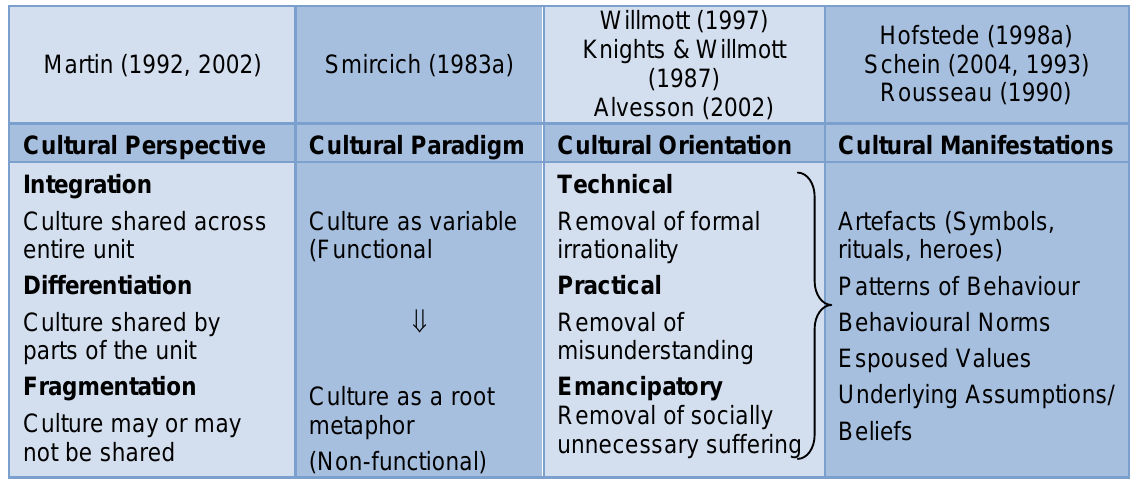
Table 1 Cultural analysis of organisations: a synthesis and research